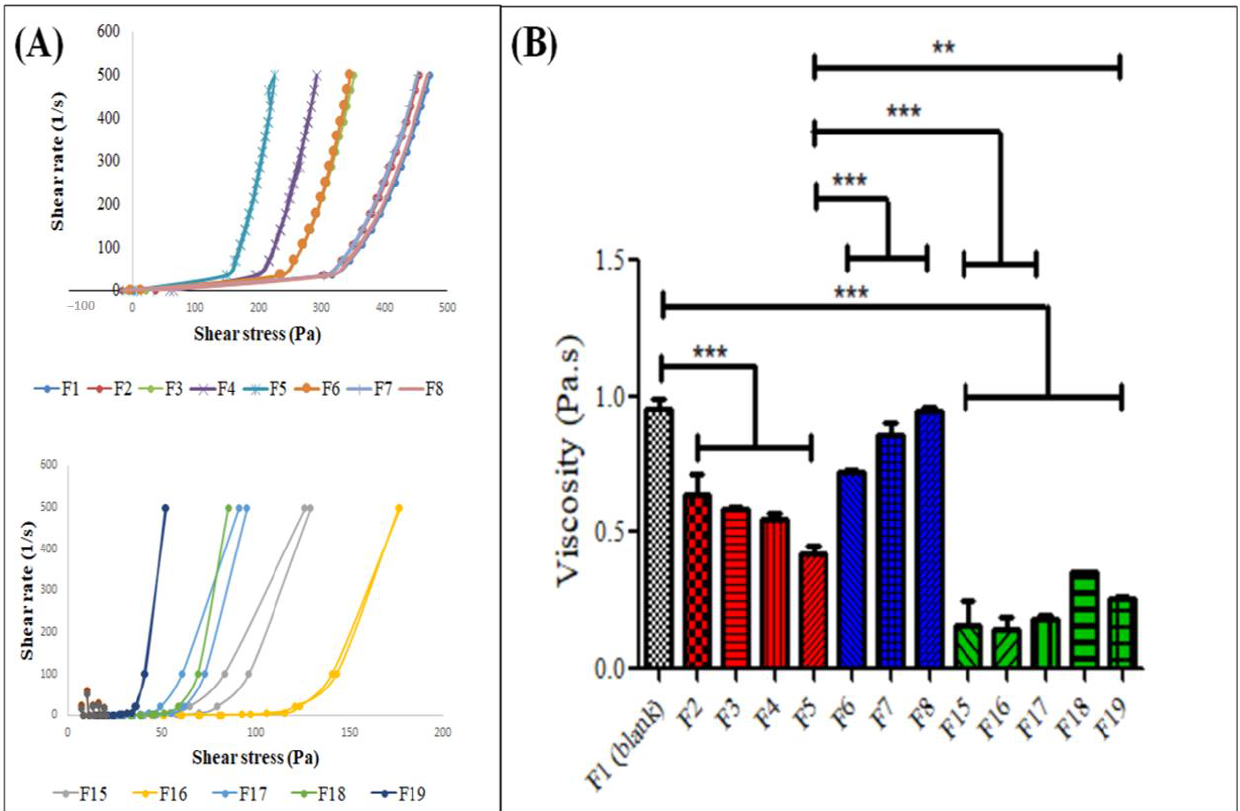
Figure 2. ( A ) Rheological profile and ( B ) viscosity of thermoresponsive gels of different formulations and containing the natural extracts at 25 °C, n = 3. ** and *** indicate significant differences at p < 0.05 and 0.01, respectively. 0.01,